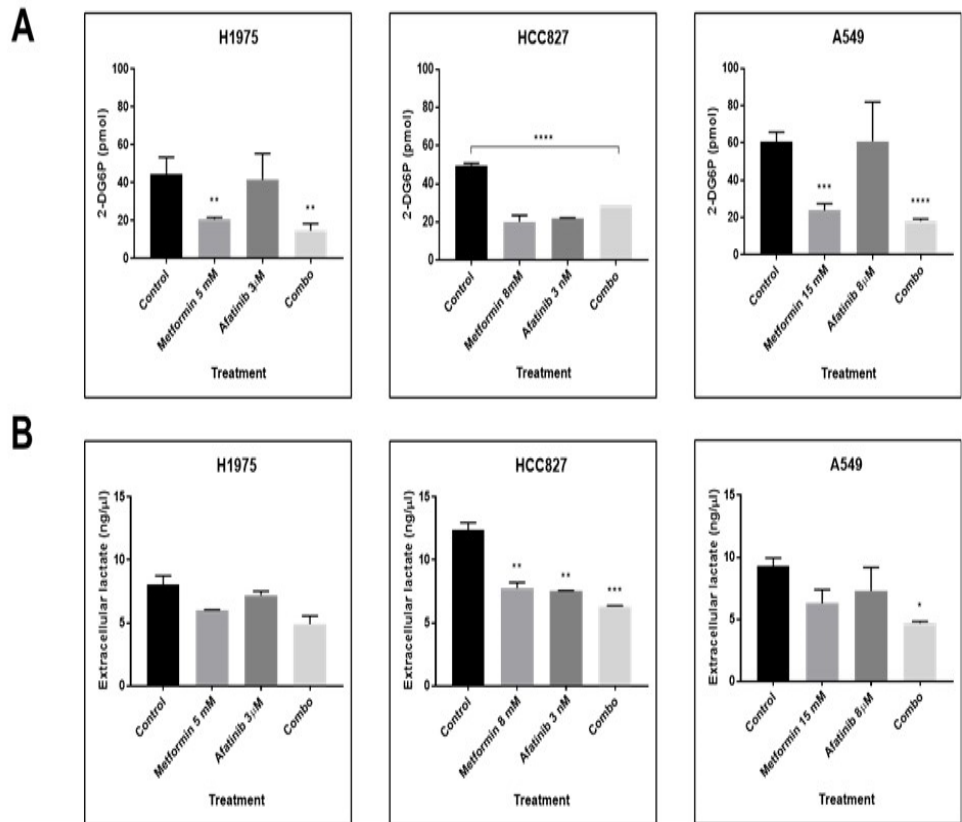
Figure 7. Cell glucose uptake and lactate secretion modifications. ( A ) For the glucose uptake assay, cells were seeded and metformin–afatinib treatment was administered in KRPH buffer over 3 h, then 2-DG6P was added and later its consumption was evaluated by ELISA. ( B ) Cells were seeded and later treated with metformin–afatinib for 3 h, levels of lactate present in the culture medium were measured by ELISA. Graphs represent the means of two independent experiments by duplicate. One-way ANOVA analysis was performed in order to determine statistical significance * p ≤ 0.05, ** p ≤ 0.01, *** p ≤ 0.001, **** p ≤ 0.0001.